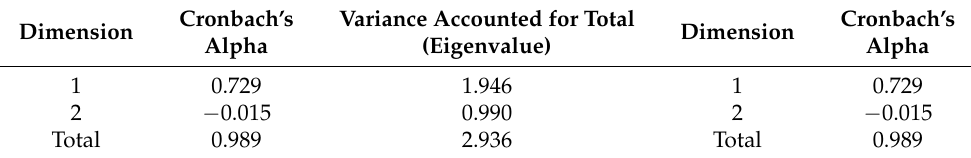
Table 2. Cronbach’s alpha value.